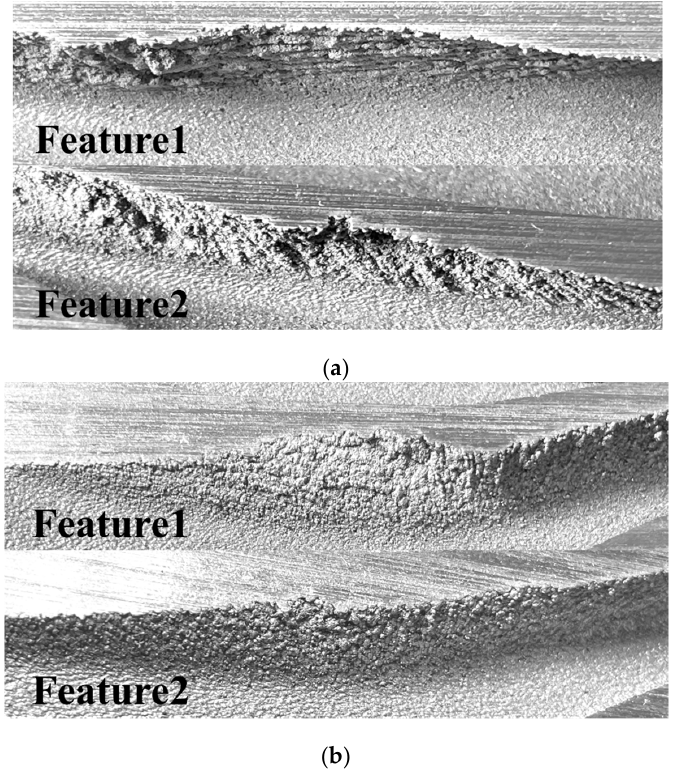
Figure 24. Close-up images of segmented sample 2 and named features: ( a ) upper region of segmented sample 2 and two collapse regions, feature1 and feature2; ( b ) lower region of segmented sample 2.